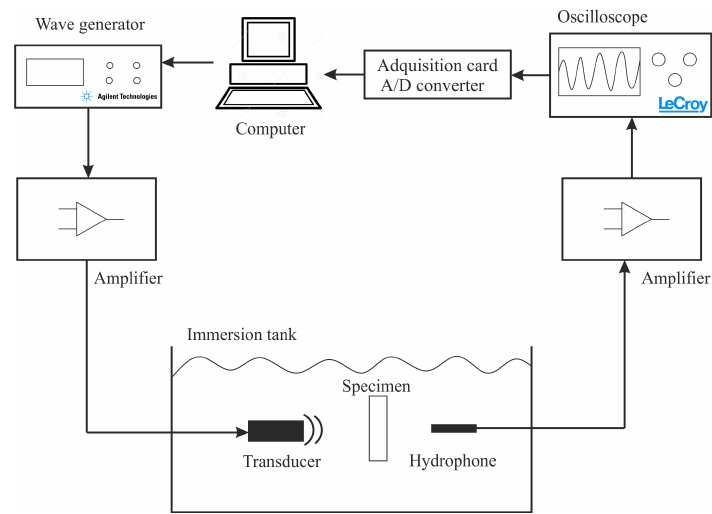
Figure 1. Experimental setup.